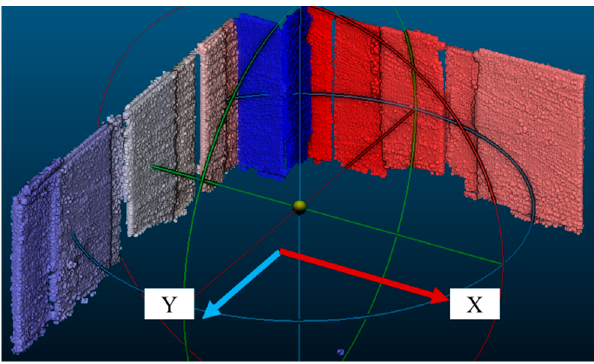
Figure 16. Over-segmentation of walls.